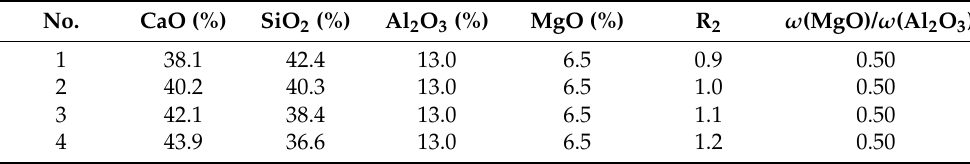
Table 1. Chemical composition of the CaO–SiO 2 –Al 2 O 3 –MgO slag system.